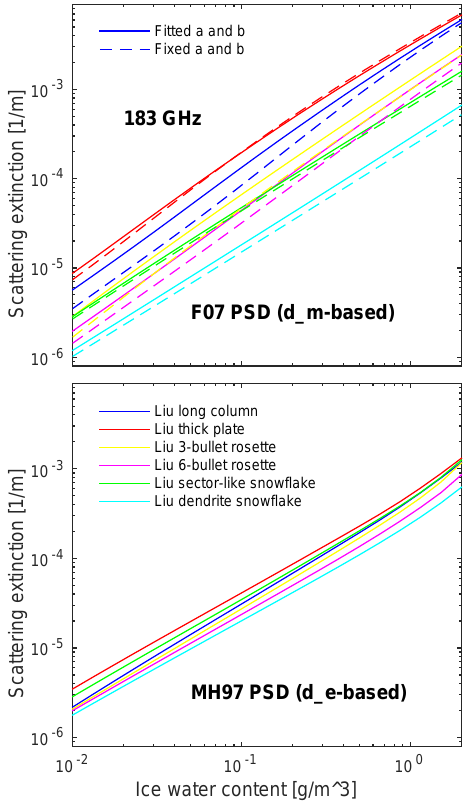
Figure 12. Scattering extinction as a function of ice water con- tent at 183GHz for some of the particles of the Hong et al. (2009) DDA database. The particle size distribution applied in the upper and lower panels is F07 (Field et al., 2007) and MH97 (McFar- quhar and Heymsfield, 1997) respectively. Dashed lines in the up- per panel show results for the F07 distribution with fixed a = 0 . 069 and b =